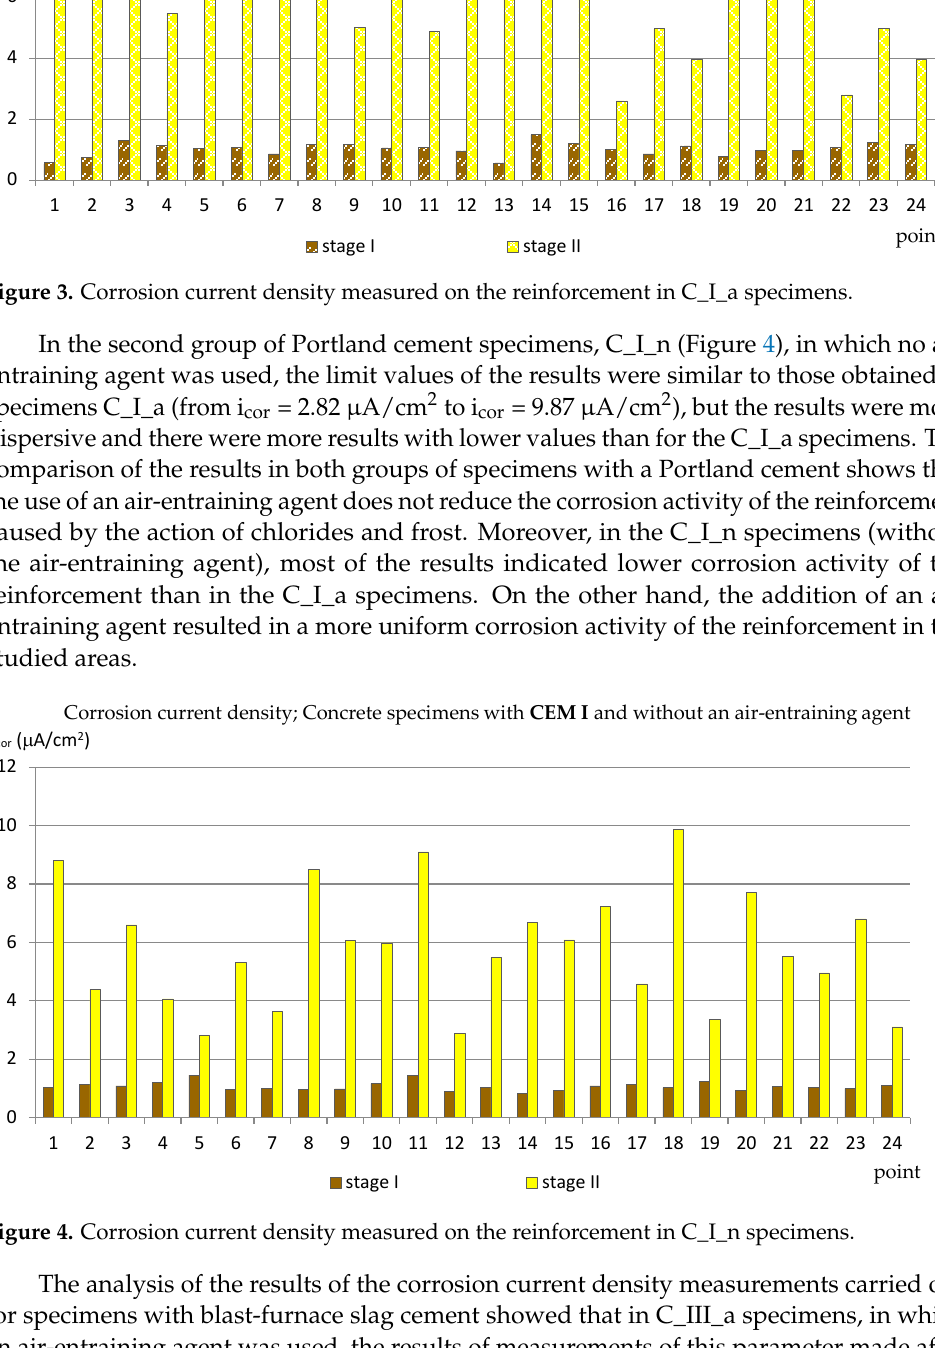
Figure 4. Corrosion current density measured on the reinforcement in C_I_n specimens. The analysis of the results of the corrosion current density measurements carried out for specimens with blast-furnace slag cement showed that in C_III_a specimens, in which an air-entraining agent was used, the results of measurements of this parameter made after 120 cycles of freezing and thawing specimens in a 3% sodium chloride solution increased only slightly in relation to the reference measurements (Figure 5). At most measuring points, the corrosion current density did not exceed i cor = 2.0 µ A/cm 2 , which pointed